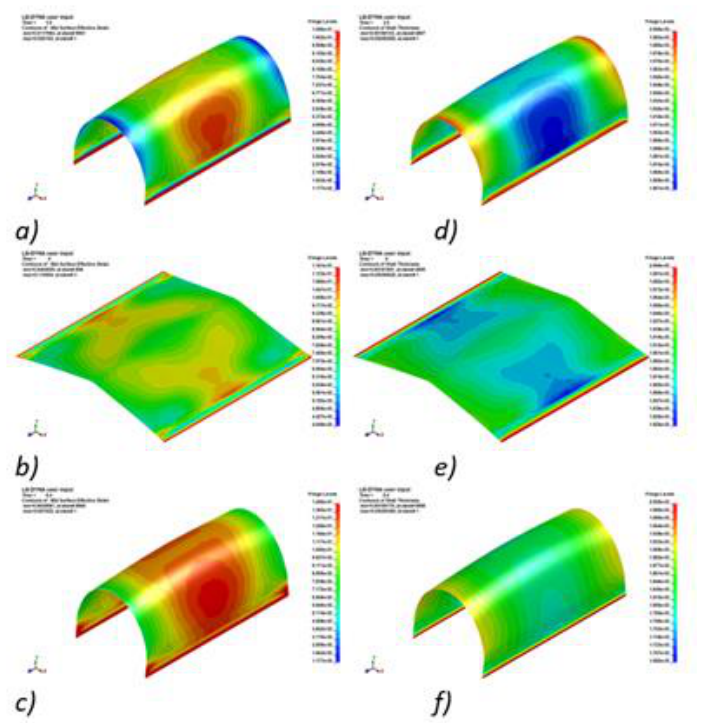
Figure 5. Distributions of experimental data 1 from the first kinematic scheme in the following stages: after the first skinning by an angle of 900 (a, d), after the part is bent through the angle 120 and its extension (b, e), at the end of the molding operation (c, f); a, b, c - distribution of effective deformations along the middle shell surface; d, e, f is the shell thickness